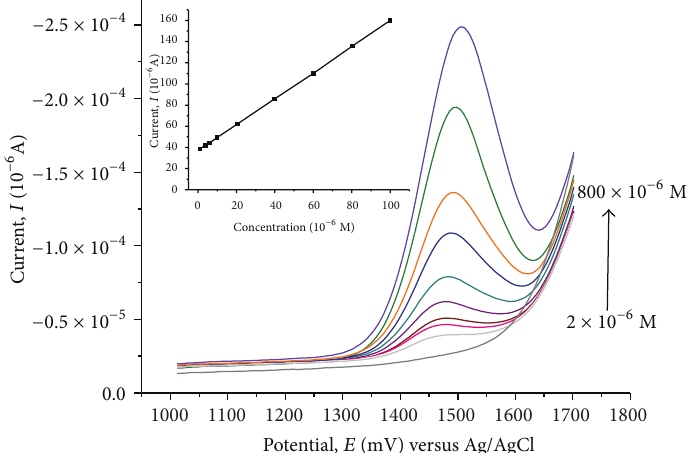
Figure 7: SWVs of AQMCPE in 0.1MHClO 4 (pH 0.56) for different concentration of caffeine (2, 4, 6, 10, 20, 40, 60, 80, 100, 300, 500, and 800 𝜇 M) at optimized parameters (inset is the linear calibration plot between peak current and concentration of caffeine in the range of 2 − 800 𝜇